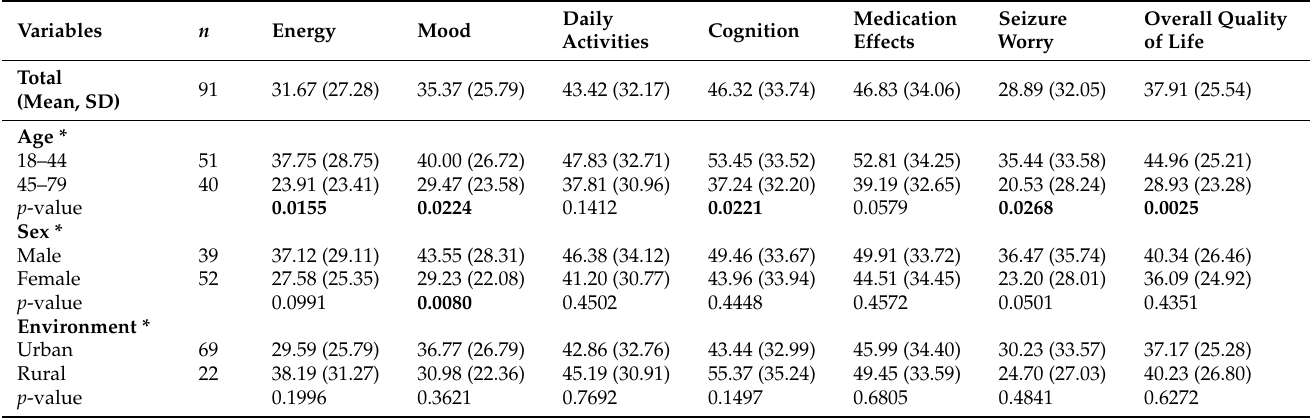
* Chi-2 test. ** Independent t -test for 2 groups and ANOVA for >2 groups. The bold p -values (<0.05) represent significant difference between groups with regards to a domain score. Mean QOLIE-31-P TS of the respondents was 64.89 ( ± 14.72). For the energy domain the score was 31.67 ( ± 27.28), for mood 35.37 ( ± 25.79), for the daily activities domain 43.32 ( ± 32.17), for cognition 46.32 ( ± 33.74), for medication effects 46.83 ( ± 34.06), for the seizure worry domain 28.89 ( ± 32.05) and for the overall QOL domain 37.91 ( ± 25.54). Twenty-three- point-one percent ( n = 21) of patients had low QOL, 49.5% ( n = 45) had average and 27.5% ( n = 25) had high QOL. The correlation of QOL scores across the domains are shown in Table 2. Comparing the two age groups, patients aged 44–79 years had lower scores on the energy, mood, cognition, seizure worry and overall QOL domains. Compared with males, females had lower scores on the mood domain. Being ill-health retired was associated with poor scores on the mood, daily activities, cognition, seizure worry and overall QOL domains. Patients with elementary school (4 years of study) and those with middle school (8 years of study) had low scores in overall QOL domain. Seizure frequency was negatively correlated with almost all QOLIE-31-P domains, except for the medication effects domain; those who had two or more seizures per month reported the lowest values in energy, mood, daily activities, cognition and seizure worry domains. Uncontrolled seizures predicted lower scores in mood, daily activities, cognition, seizure worry and overall QOLIE domains. These results are supported by statistically significant values of p less than 0.05. Table 2. Socio-demographic, clinical features and QOLIE-31-P